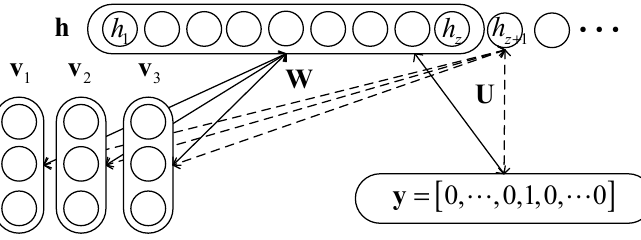
Figure 2. Graphical structure of the Dis-iRBM for sequential HRRP.